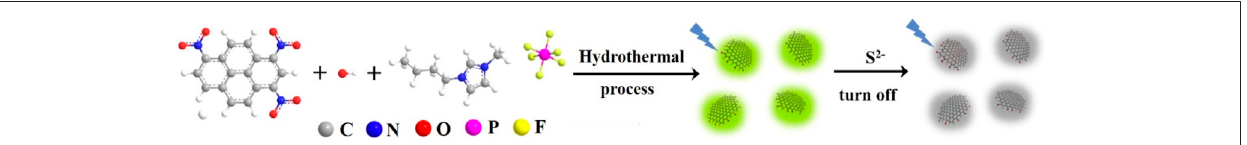
FIGURE 1 | Schematic illustration for one-step preparation of fl uorescent IL-GQDs nanocomposites and their application for detection of S 2 − based on fl uorescence turn